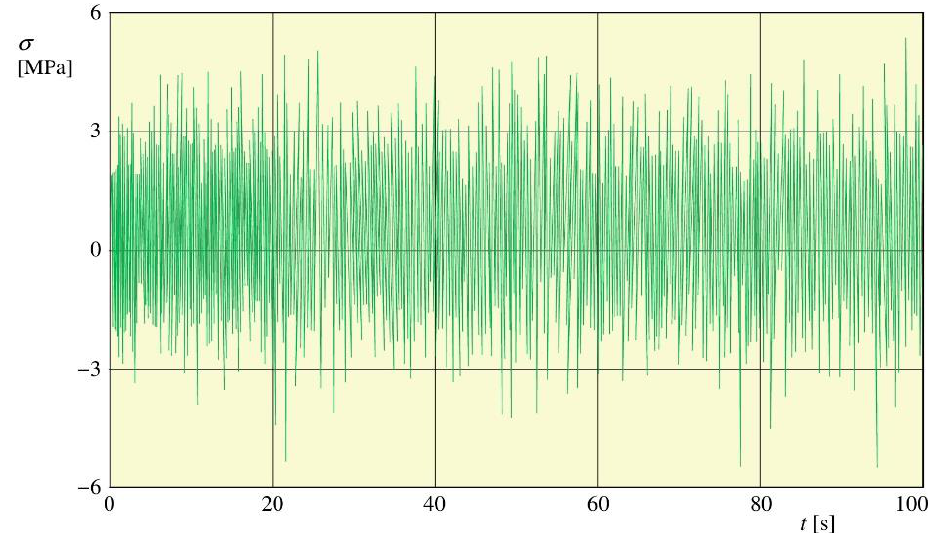
Figure 8. Time dependence of stresses expressed from measured strains.